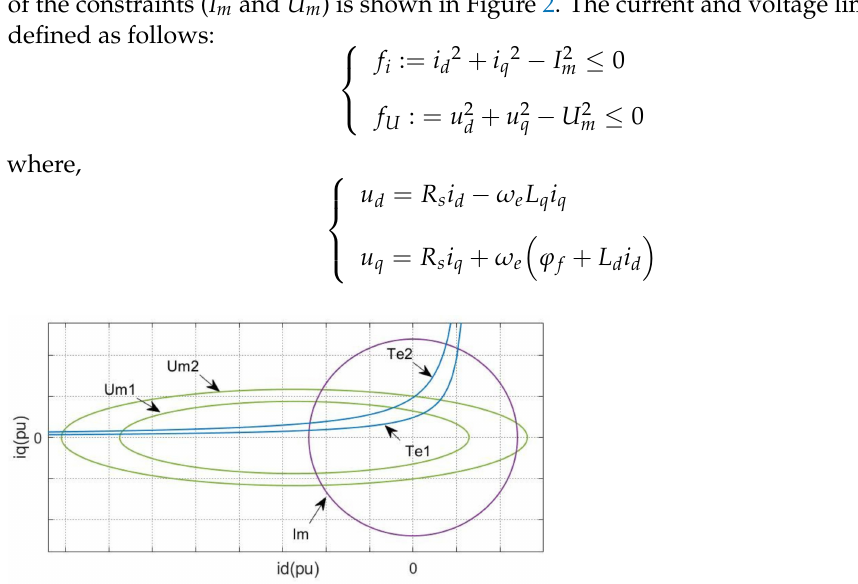
Figure 2. Feasible domain. Electrical torque: Te2 > Te1, Um1 and Um2: voltage limitations, and Im: maximum current